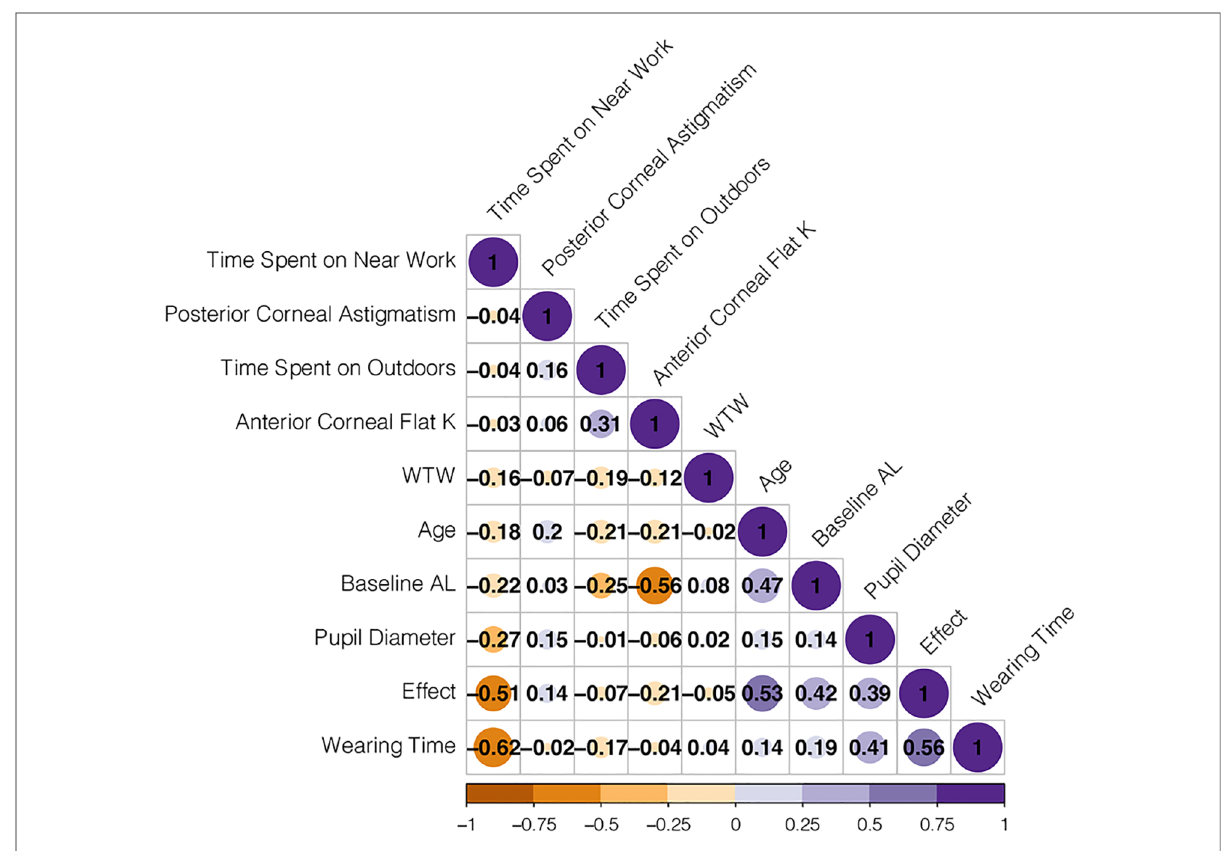
FIGURE 2 Heat map of correlation coef fi cient after logistic regression model. K, keratometry; WTW, white-to-white distance; AL, axial length. The fi gures are Pearson coef fi cients. The larger the absolute value of the fi gure, the stronger the relationship. The minus sign represents a negative relationship; the plus sign represents a positive relationship. For example, − 0.51 represents a negative relationship between time on near work and